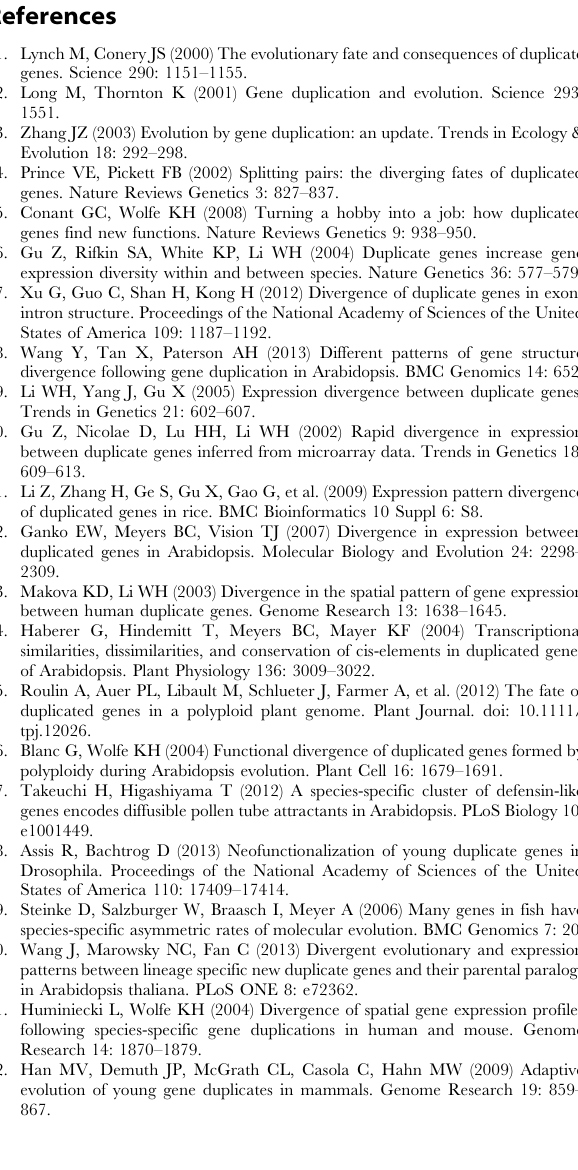
Table S4 Expression values in the seven tissues studied. Table S5 Cattle-specific duplicate genes that rapidly diverged in